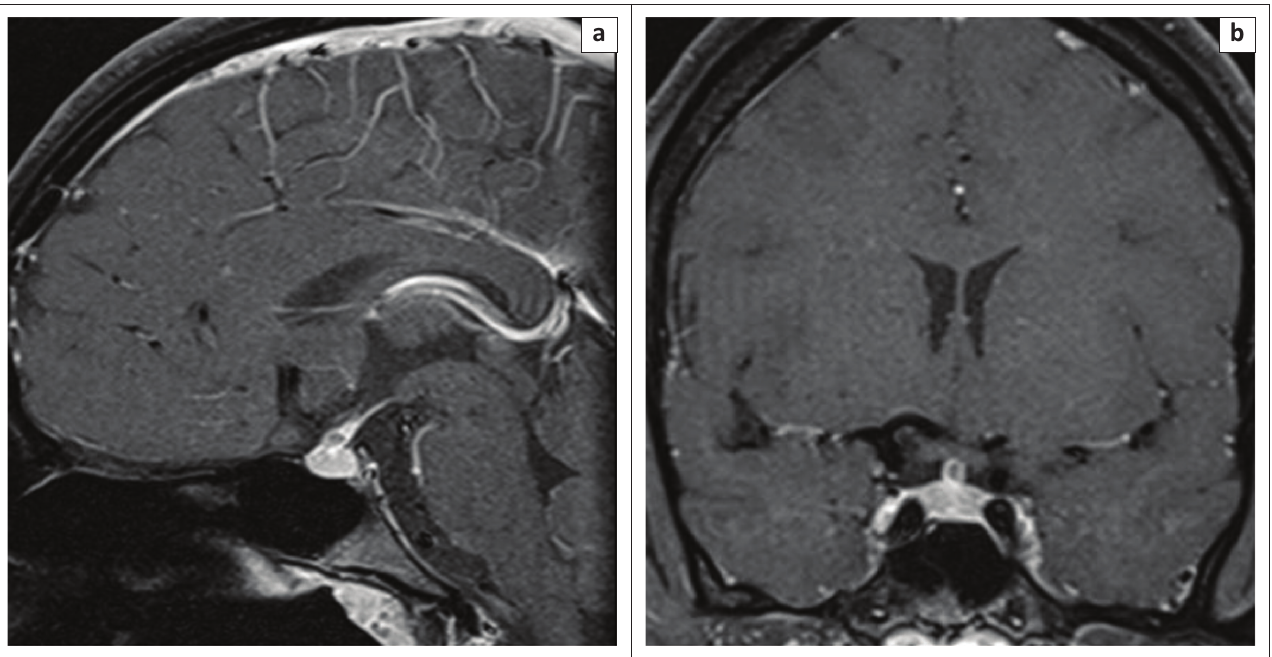
FIGURE 2: (a) Sagittal post-contrast T1-weighted image defines the adenoma in the distal part of the thickened pituitary stalk. The adenoma enhances less than the stalk and the gland; (b) Coronal dynamic contrast-enhanced image reveals a hypo enhancing mass in the pituitary stalk. There is no significant compression of the optic chiasm.